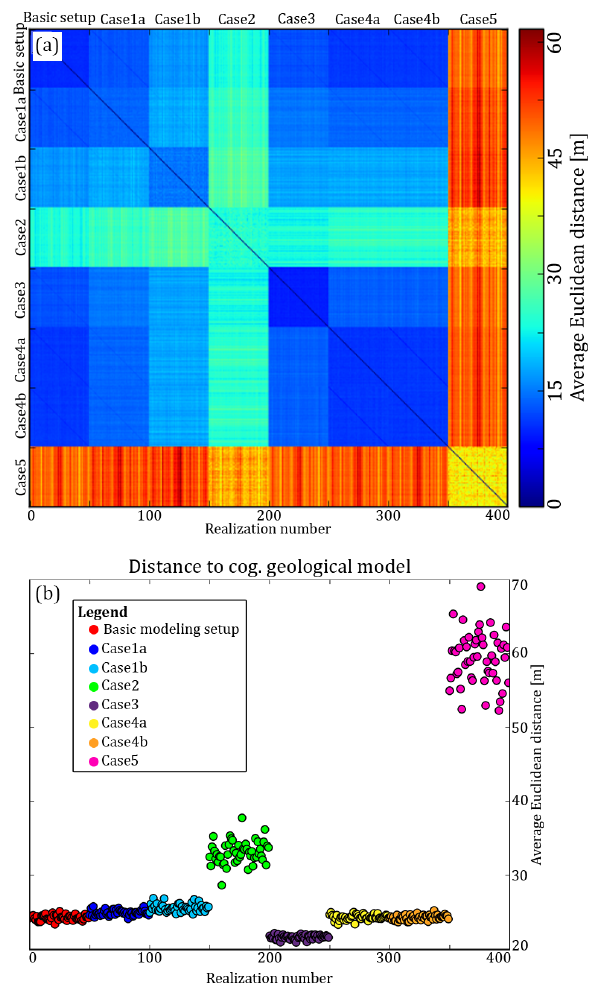
Figure 11. A presentation of the average Euclidean distance calcu- lations. (a) shows the full distance matrix; (b) shows the average Euclidean distances between each individual hydrostratigraphic re- alization and the cognitive geological